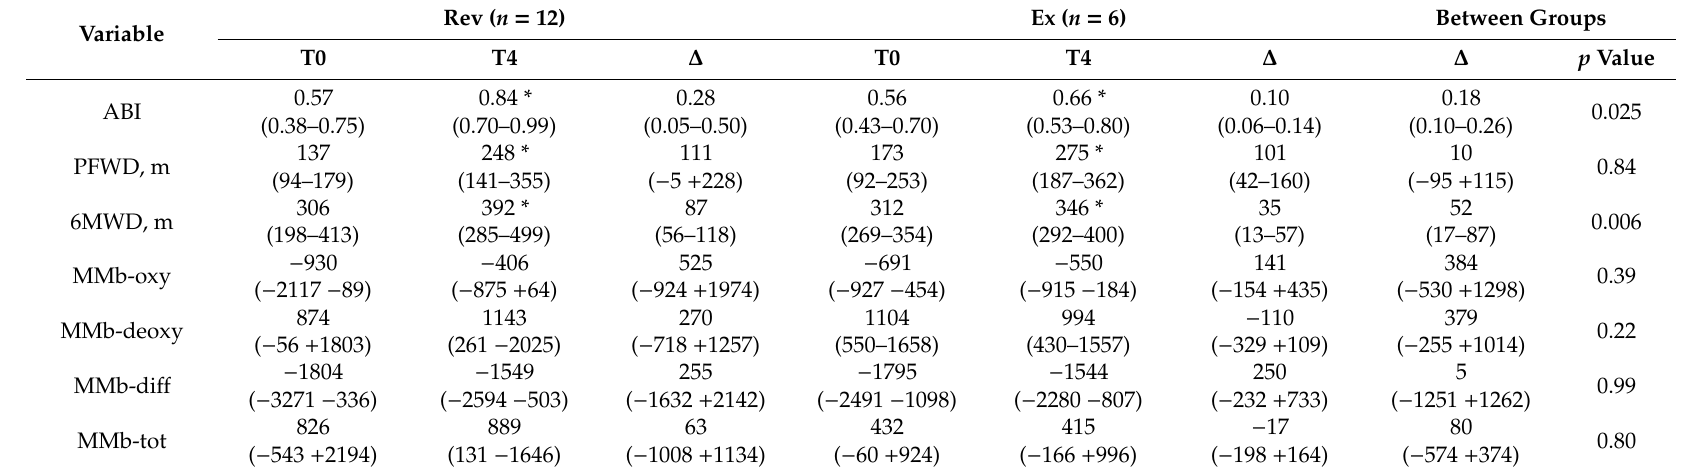
Table 2. Outcome measures values before and after